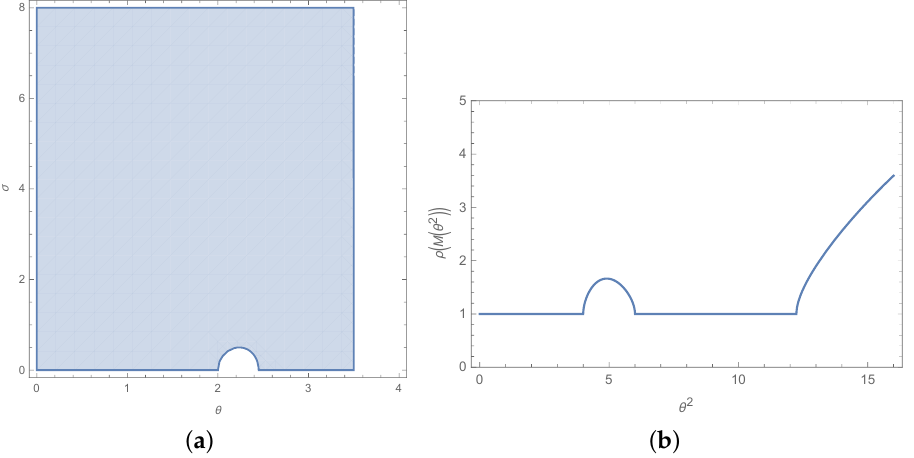
Figure 2. ( a ) The stability region for the simplest 3-step block method plotted in the ( θ , σ ) -plane and ( b ) the periodicity interval for the simplest 3-step block method plotted in the ( θ 2 , ρ ( M ( θ 2 ))) -plane when δ = 0 ( σ =